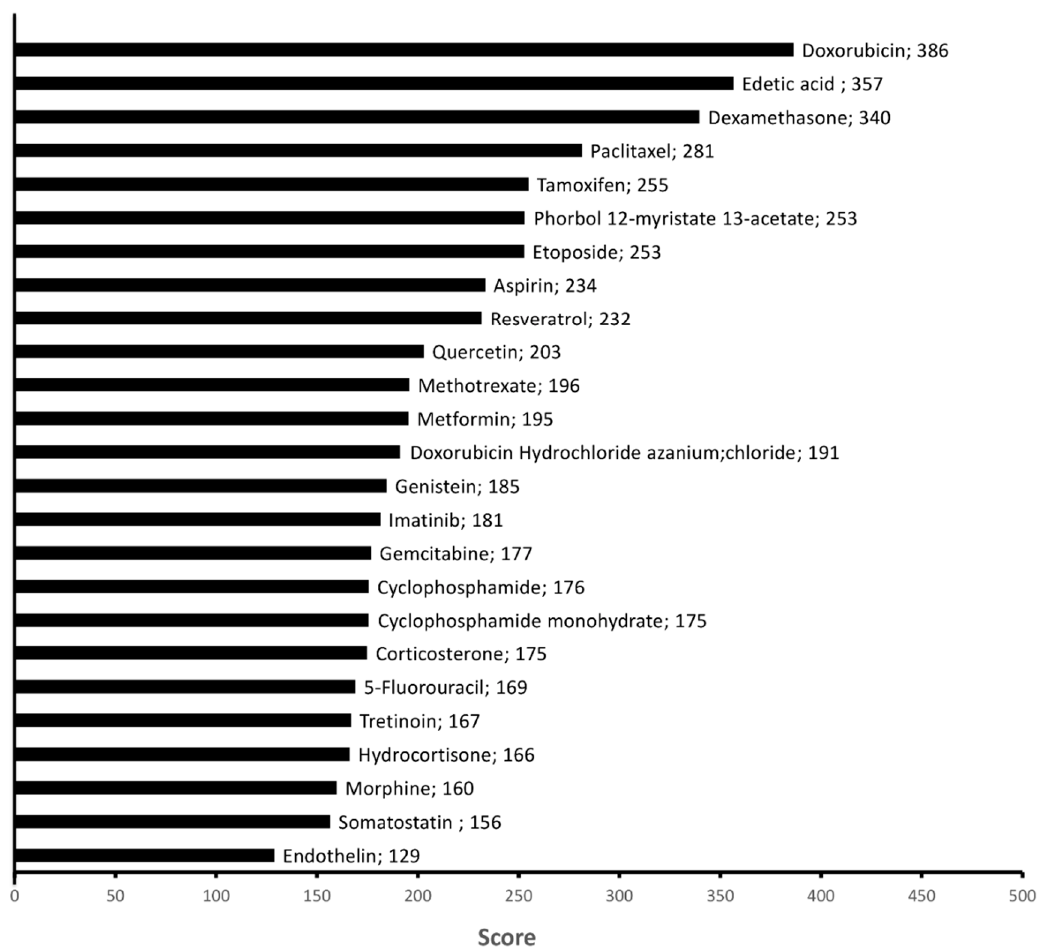
Figure 6. Classification of drugs targeting metabolic protein networks modulated by TSA and NAM in hypoxia conditions. The classification of chemicals is done through a deep machine learning according to their link to bronco-alveolar adenocarcinoma and cell metabolism processes (ATP metabolic process (GO:0046034), oxidation–reduction process (GO:0055114), carbohydrate metabolic process (GO:0005975), lipid metabolic process (GO:0006629), and cellular protein metabolic process (GO:0044267)). Five hundred chemicals were classified. A high score symbolized a high link of the chemical with the cell metabolism process and our protein network. The classification presented here was obtained by extracting drugs obtained by our machine learning analysis in the top 70 rank of chemicals related to MESH: D002282 pulmonary adenocarcinoma with exclusion of chemicals/metabolites. The top 70 rank ensures a high link between the chemical and data reported on these chemicals in the literature in broncho-alveolar adenocarcinoma (MESH: D002282 pulmonary adenocarcinoma).